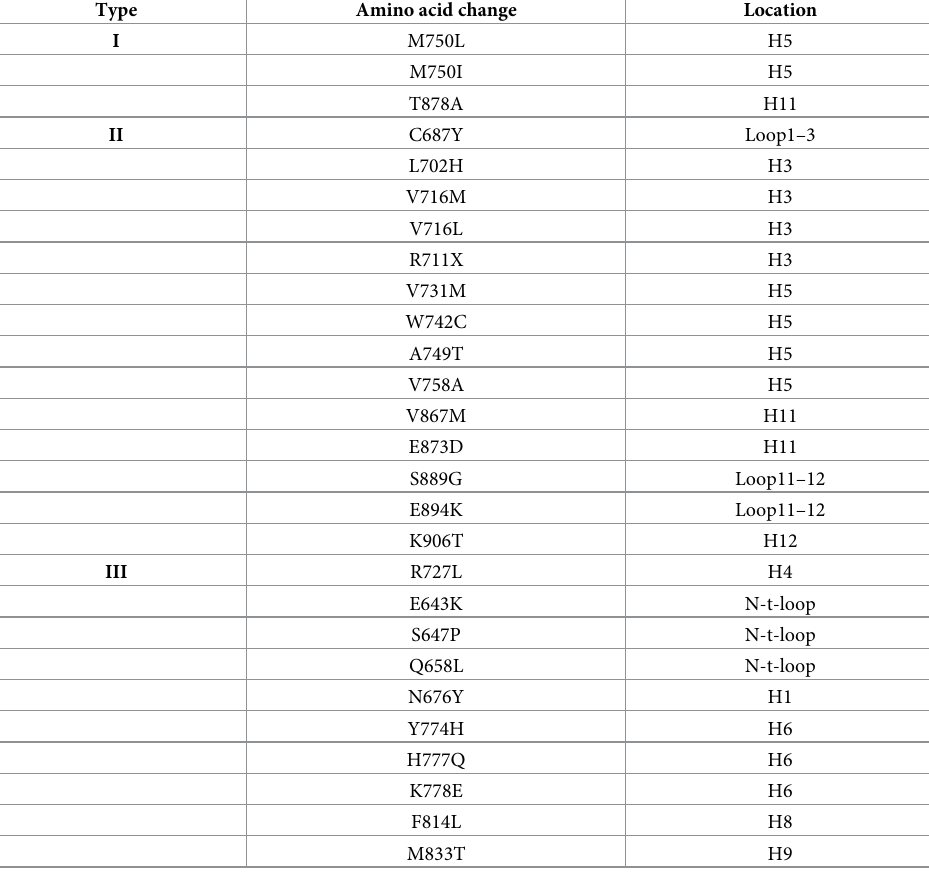
Table 2. Summary of known and novel AR-LBD mutations based on protein